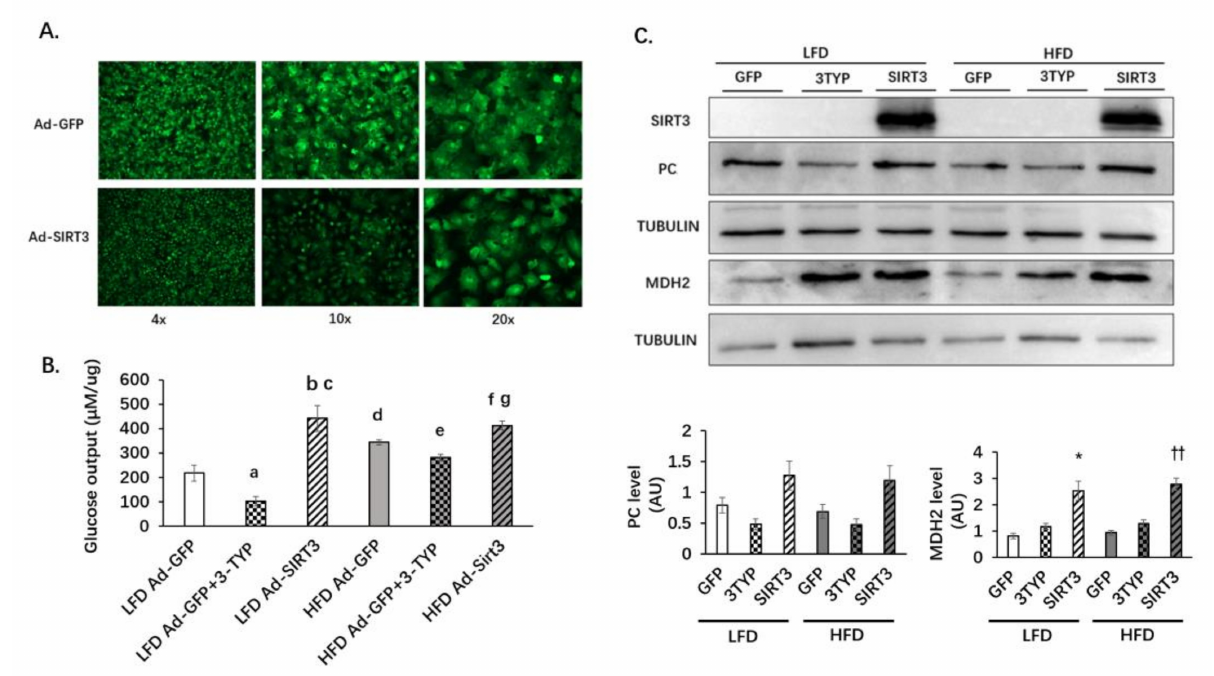
Figure 8. SIRT3 overexpression increases glucose production and the protein level of MDH2 in primary hepatocytes. Primary hepatocytes from HFD or LFD mice were isolated and infected with Ad-GFP or Ad-SIRT3 adenovirus. ( A ) Infection status after 48 h as fluorescent detection of GFP. ( B ) Glucose production from primary hepatocytes. In the presence of substrates (20 mM lactic acid and 2 mM pyruvate), the primary hepatocytes were stimulated with 100 nM glucagon for 3 h with or without 50 uM 3-TYP treatment for 24 h. a, p < 0.05, LFD Ad-GFP vs. LFD Ad-GFP+3-TYP; b, p < 0.05, LFD Ad-GFP vs. LFD Ad-SIRT3; c, p < 0.05, LFD Ad-GFP+3-TYP vs. LFD Ad-SIRT3;